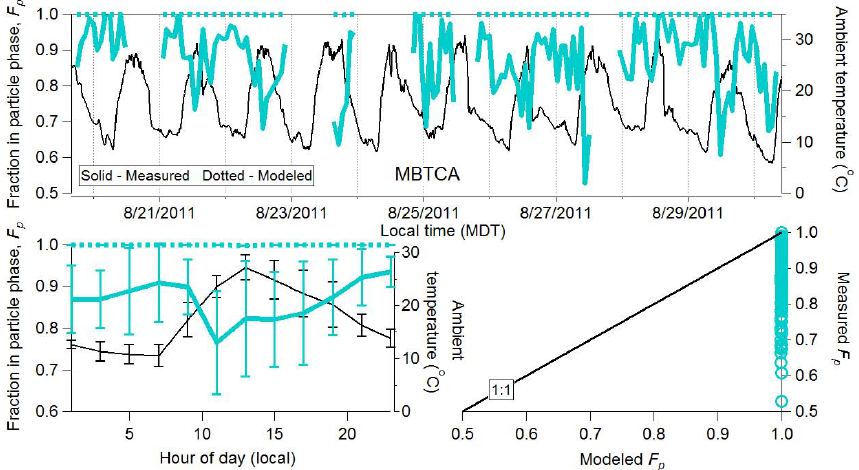
Fig. 14. Time series, diurnal cycle, and scatter plot of measured and modeled F p for C 8 H 11 O −